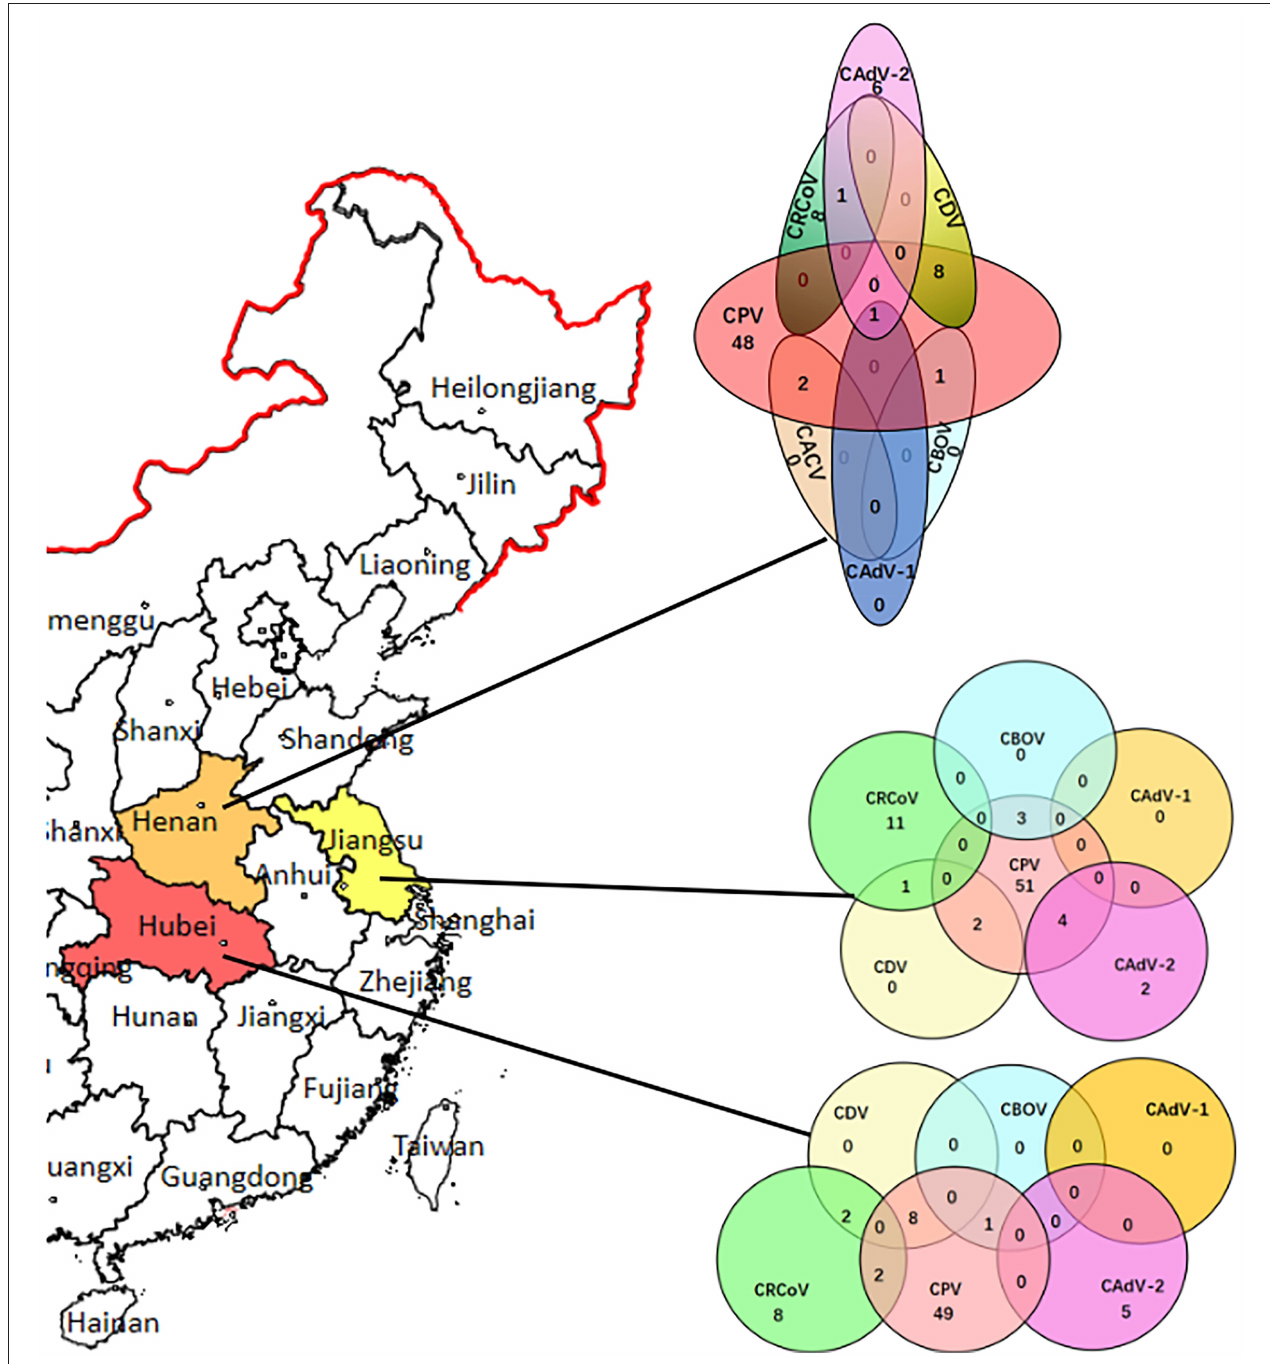
FIGURE 1 | CAdV distribution in China and the infection rates and co-infection status of CPV-2, CDV, CBOV, CRCoV, and CAdV in the Henan, Hubei, and Jiangsu provinces.